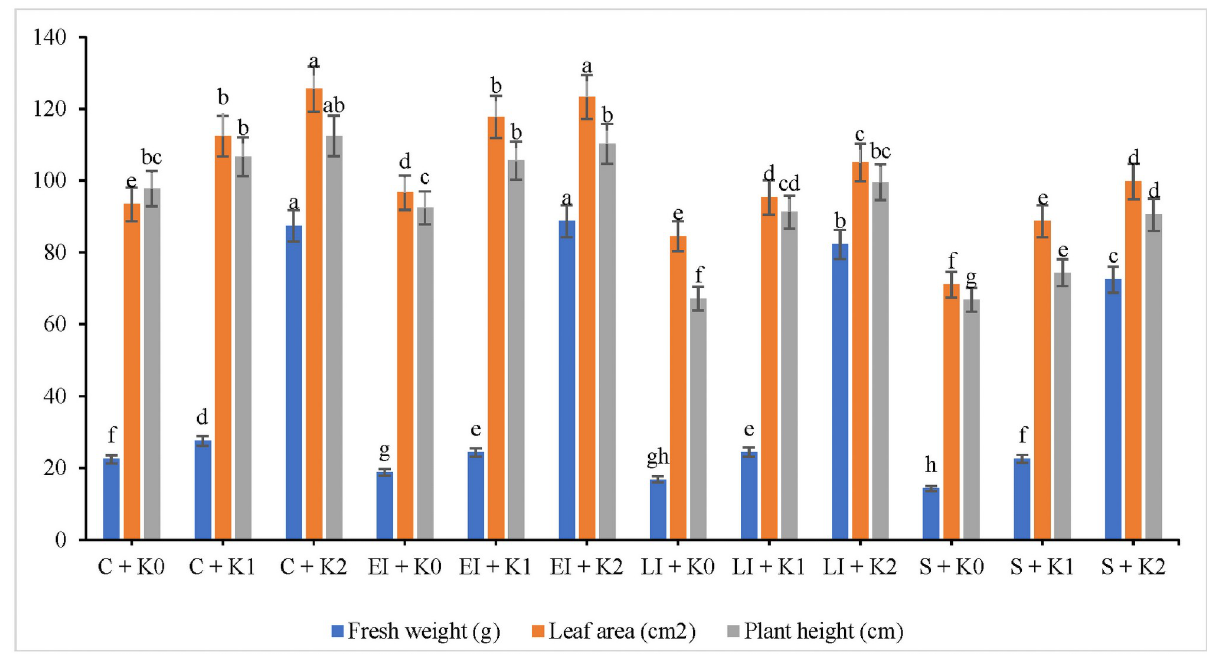
Fig 1. Mean values of fresh weight (colour, g), leaf area (cm 2 ) and plant height (cm) of the 12 treatments with different levels of irrigation (C = Control, EI = Early irrigation, LI = Late irrigation, S = Stress) and different amounts of K (kg ha –1 K 2 SO 4 ): K 0 = 0; K 1 = 10; K 2 =